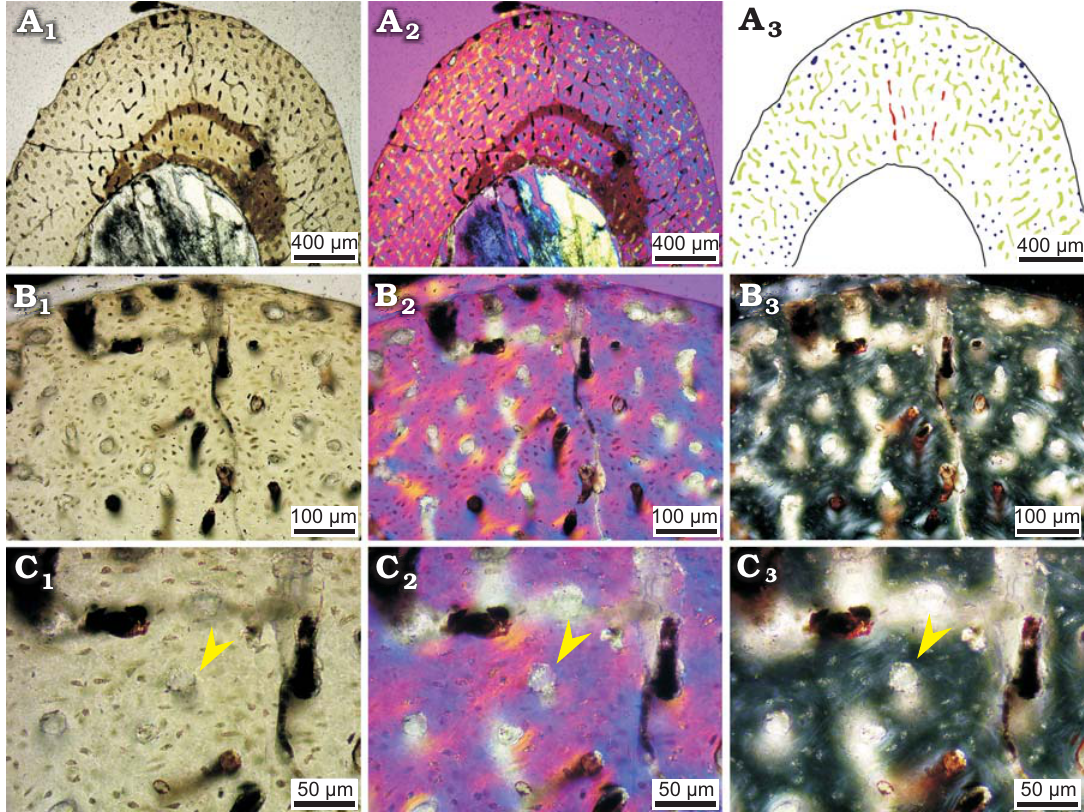
Fig. 2. Bone microstructure in hatchling ceratopsian dinosaur Psittacosaurus lujiatunensis Zhou, Gao, Fox, and Chen, 2006 (IVPP V16902.1) from west- ern Liaoning, China, Early Cretaceous. A – C . Mid-diaphyseal transverse section of tibia ( A ) and details ( B , C ); photographs in regular transmitted light (A 1 –C 1 ), elliptically polarized light (A 2 –C 2 ), crossed plane-polarized light (B 3 , C 3 ). A 3 , line drawing showing longitudinal vascular canals (navy), reticular vascular canals (green) and radial vascular canals (red). Arrows indicate simple primary vascular